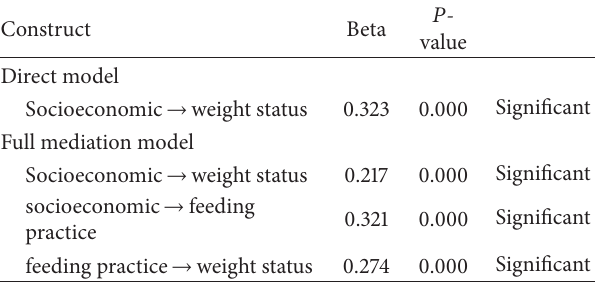
Table 12: Compression between full mediation model and direct